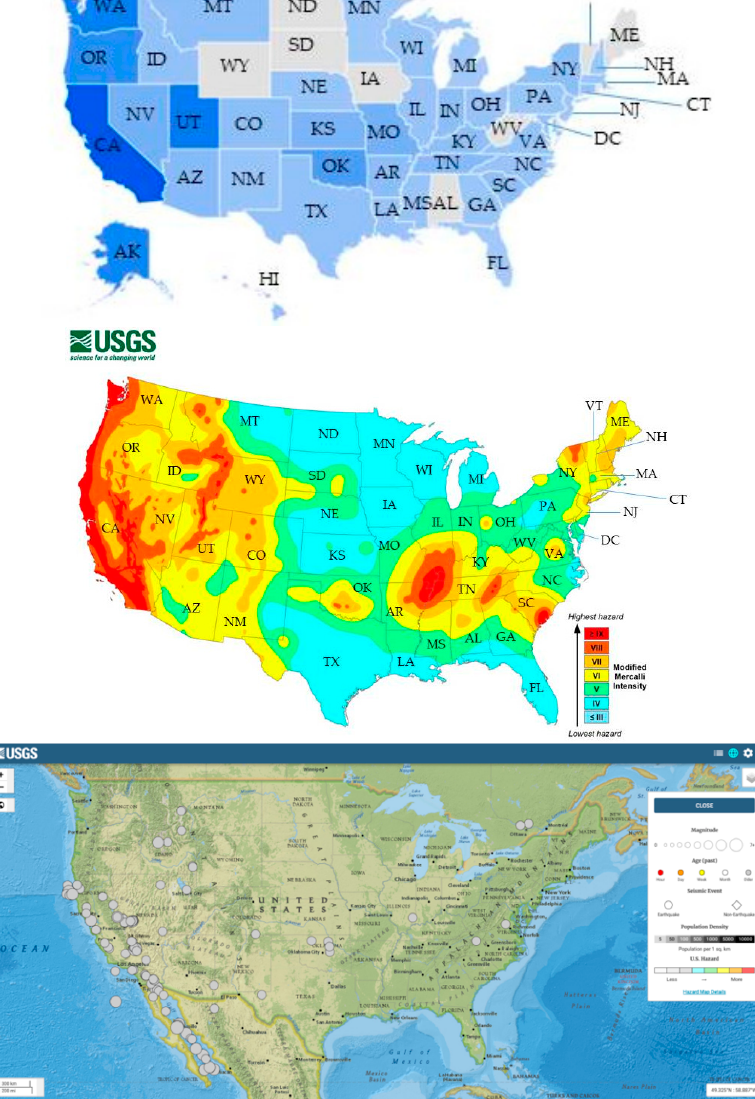
Figure 2. Comparison between the GT EQI GeoMap for the USA in 2004–2021 (( upper panel ), modi- fied from the original source), the seismic hazard map of the conterminous USA (( central panel ), mod- ified from the original source) [46], and the earthquakes occurred in the conterminous USA and surrounding areas, which are outside the conterminous USA in 2004–2021 (M ≥ 5.0) [45] ( lower panel ). In the GeoMap, darker shades indicate the states where the EQI searches were more frequent. There- fore, the states where online search was the highest were CA = 100; UT = 70; WA = 66; AK = 60; OR = 53; OK = 41; MO = 25; NV = 25; KS = 22. The seismic hazard map ( central panel ) shows the intensity (MMI scale) of potential earthquake ground shaking that has a 2% probability of occurring in 50